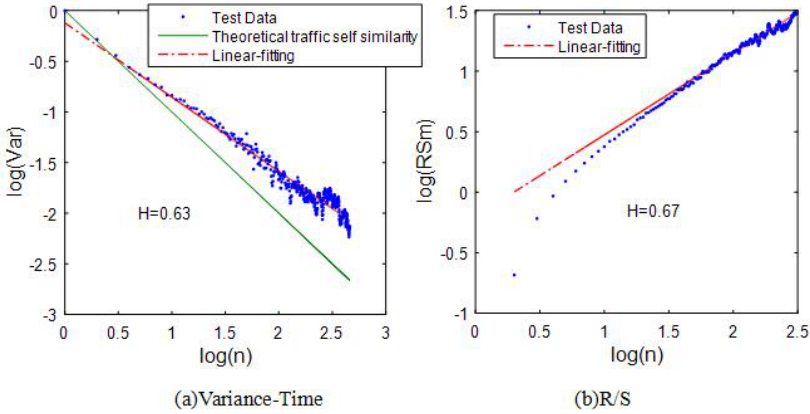
Figure 11. The Hurst index of http_load.